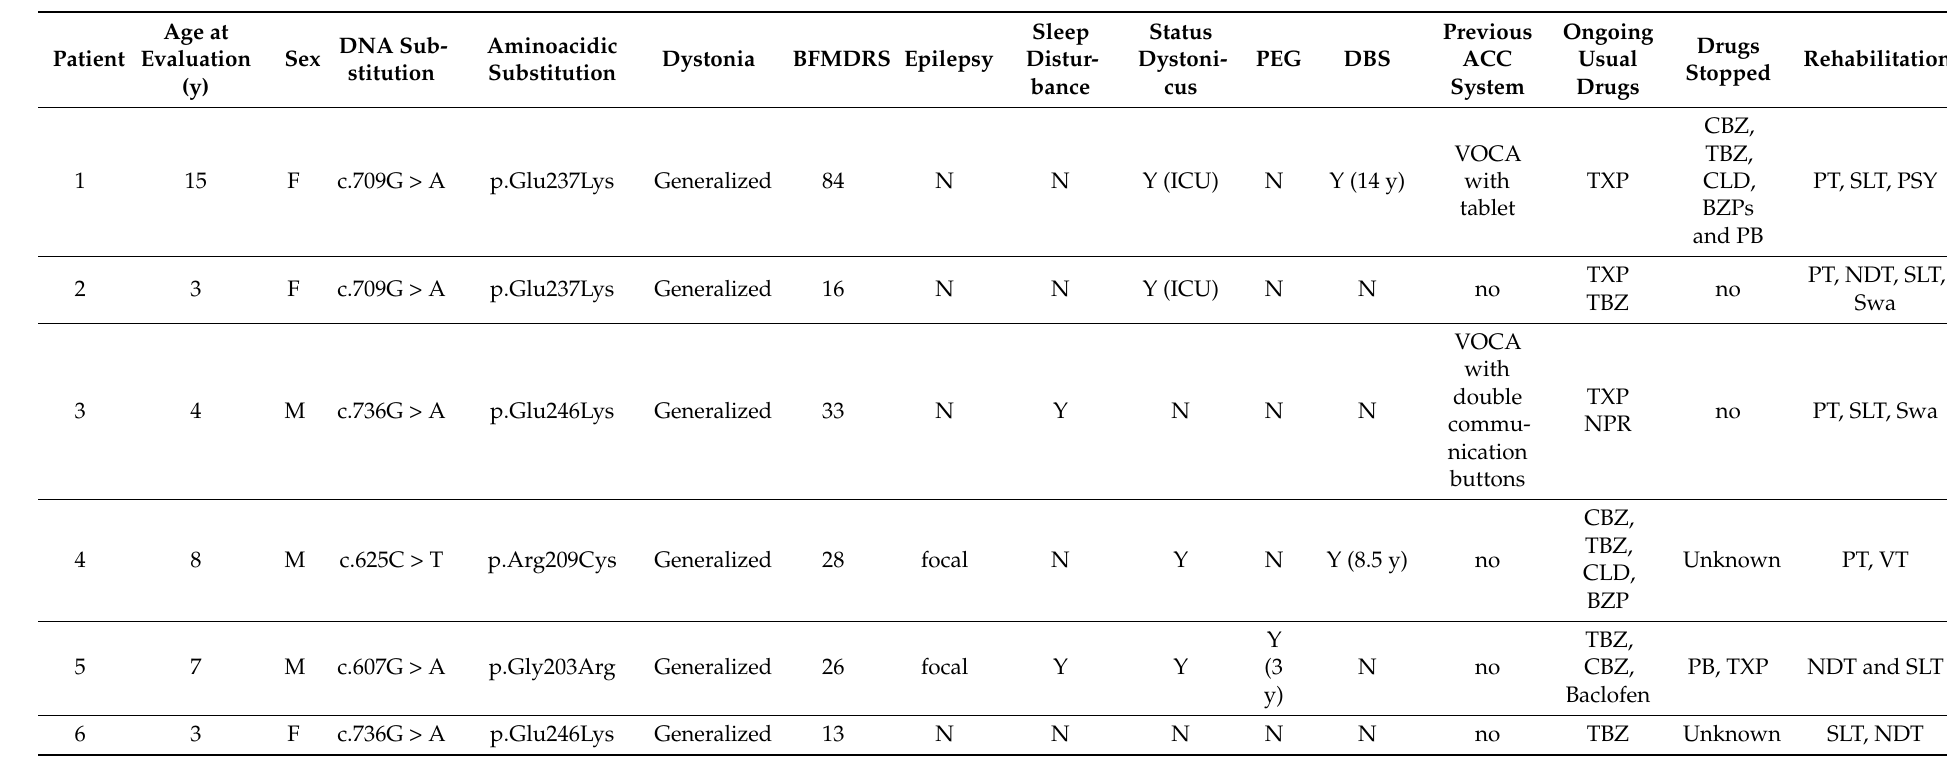
Table 1. GNAO1 cohort clinical and genetic characteristics, N: no, Y: yes, ICU: intensive care unit, BFMDRS: The Burke–Fahn–Marsden Dystonia Rating Scale, VOCA: Voice output communication aids, DBS: deep brain stimulation TXP: Trihexyphenidyl, y: years, CBZ: Carbamazepine, TBZ: Tetrabenazine, PB: Phenobarbital, CLD: clonidine, NPR: Niaprazine, BZPs: benzodiazepines PT: Physical therapy, SLT: Speech and language therapy, Psy: Psychotherapy, Swa: Swallowing therapy, NDT: Neurodevelopmental Disorders Therapist, and VT: Vision